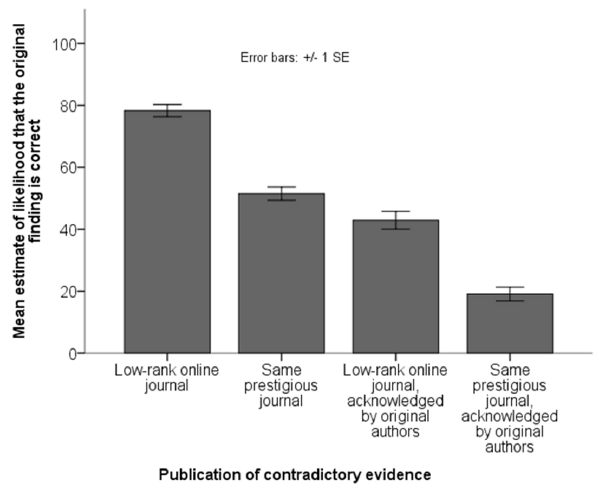
Figure 1. Results from Study 1. Belief in an original finding, for which subsequent contradictory evidence exists, depends on whether the contradictory evidence is published in the same prestigious journal as the original finding and whether the original authors acknowledge the contradictory evidence.